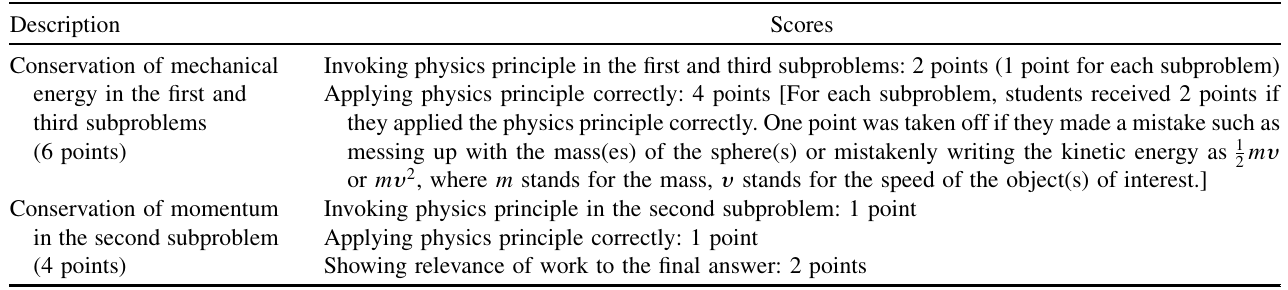
TABLE III. Summary of the rubric for the quiz problem.